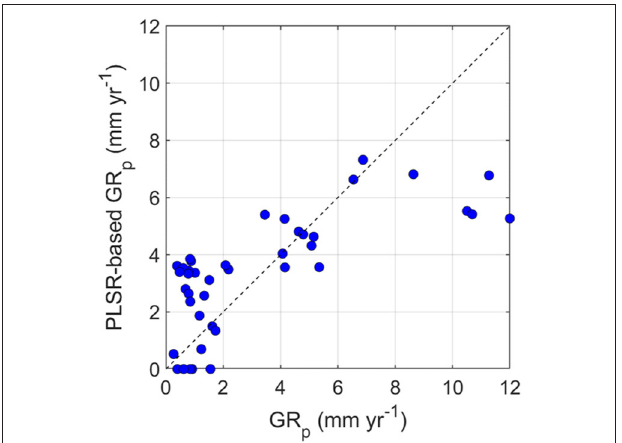
FIGURE 5 | Comparison between GR p simulated in HYDRUS-1D and modeled by using PLSR over the 41 weather stations.